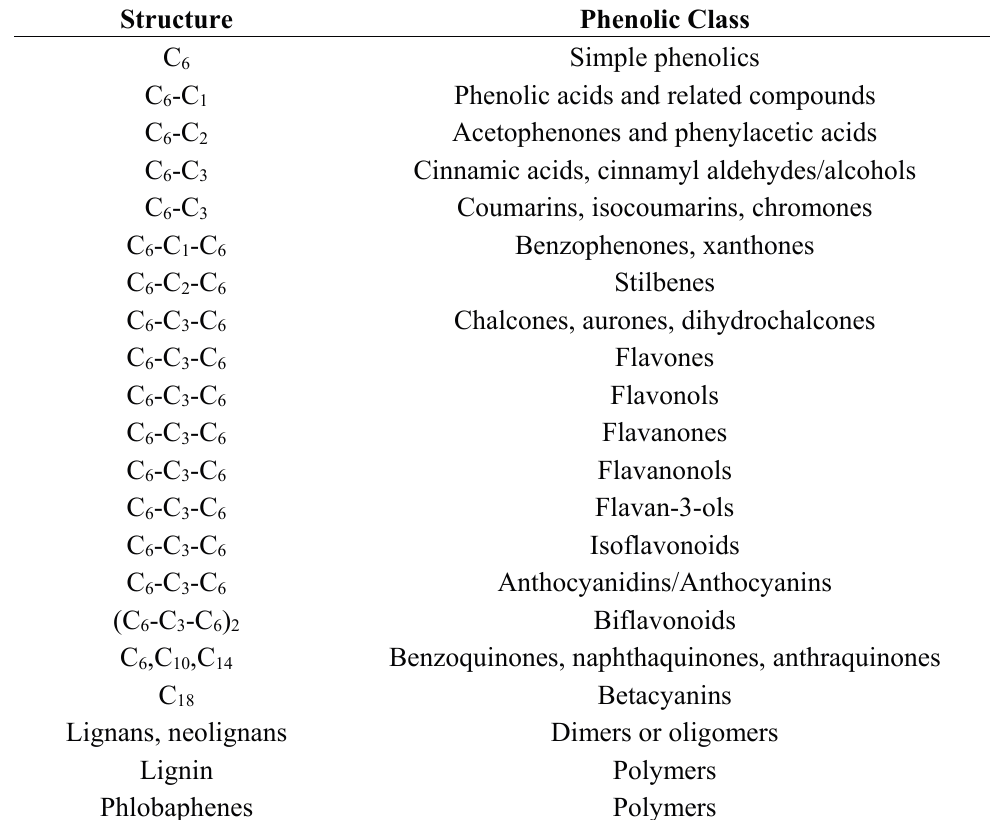
Table 1. Classification of phenolic compounds in plants